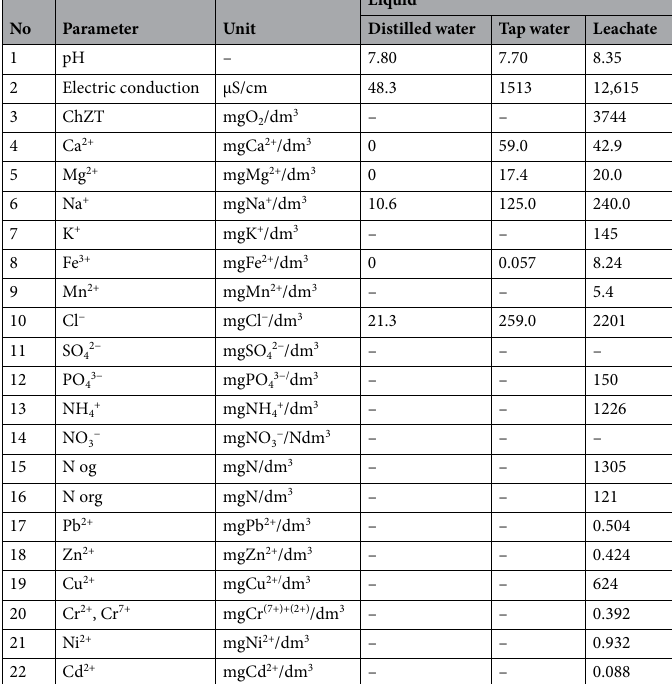
Table 3. Chemical properties of distilled water, tap water and